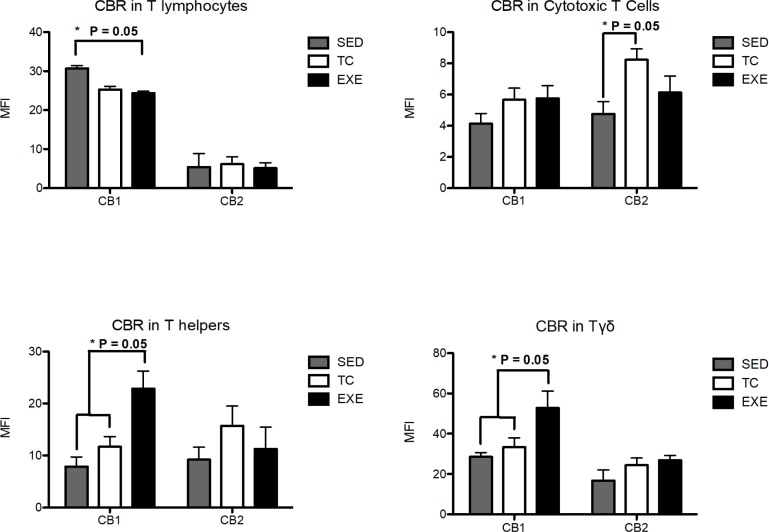
Expression of CBR in splenocyte populations related to the adaptive immune response.Analysis of the expression of CB1 and CB2 CBR in splenocyte populations from the adaptive immune response (T lymphocytes; n = 10, T helper lymphocytes; n = 8, cytotoxic T Lymphocytes; n = 10 and Tγδ n = 8) among experimental groups: SED (shaded bar), TC (white bar) and EXE (Solid bar); data from 4 independent experiments are expressed as mean ± SE. Lines connecting bars represent comparison among groups, * p<0.05. Two way ANOVA and Bonferroni post-test.